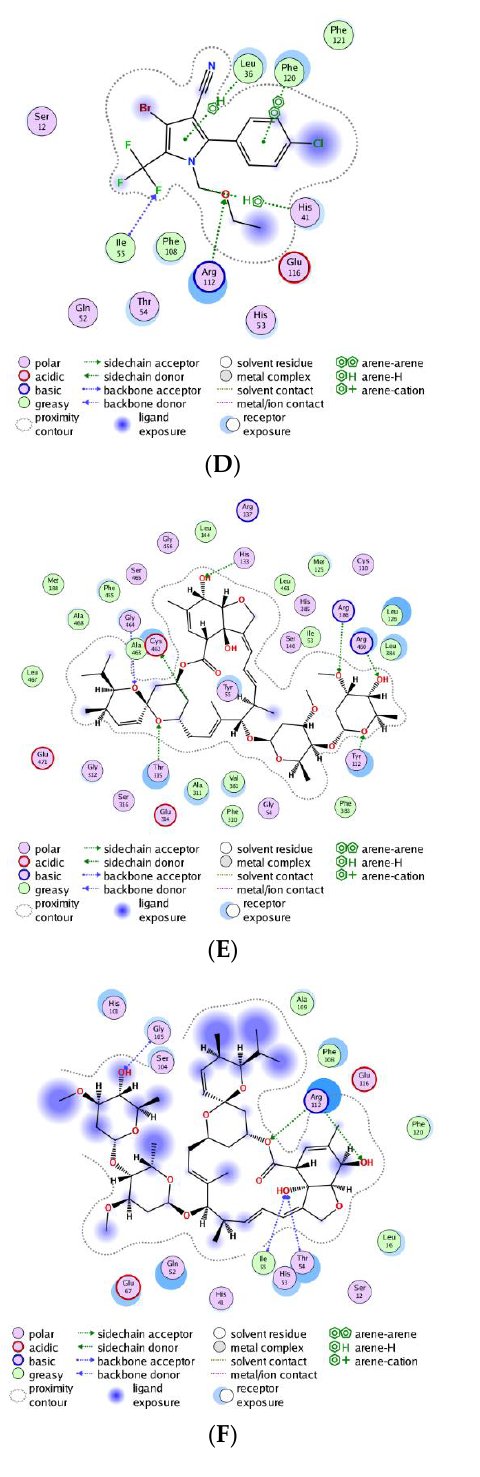
Figure 5. The 2D and 3D molecular modelling interactions of lambda-cyhalothrin ( A , B ), chlorfenapyr ( C , D ), and abamectin ( E , F ) (green in 3D interactions), with cytochrome P450 90B1 and glutathione S-transferase proteins, respectively (PDB code: 6a18 and 2imk , respectively). The hydrogen bonds are shown as dotted blue arrows; (C atoms are colored gray, S yellow, and O red).